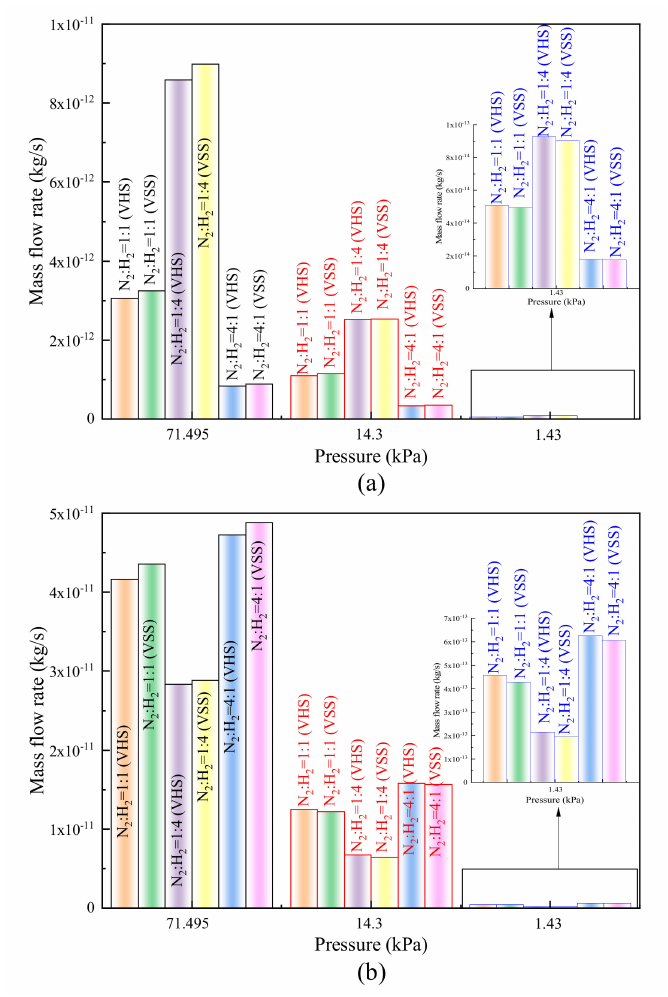
Figure 9. Mass flow rates for di ff erent pressures. ( a ) Mass flow rates of H 2 for di ff erent pressures, ( b ) mass flow rates of N 2 for di ff erent